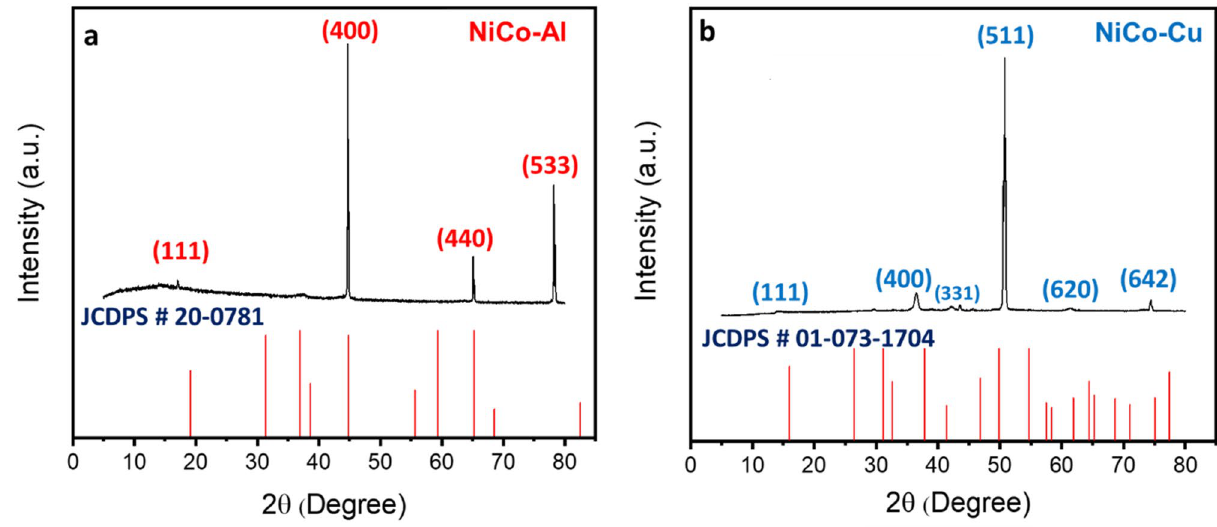
Fig. 3 X-ray diffraction of as-prepared a NiCo